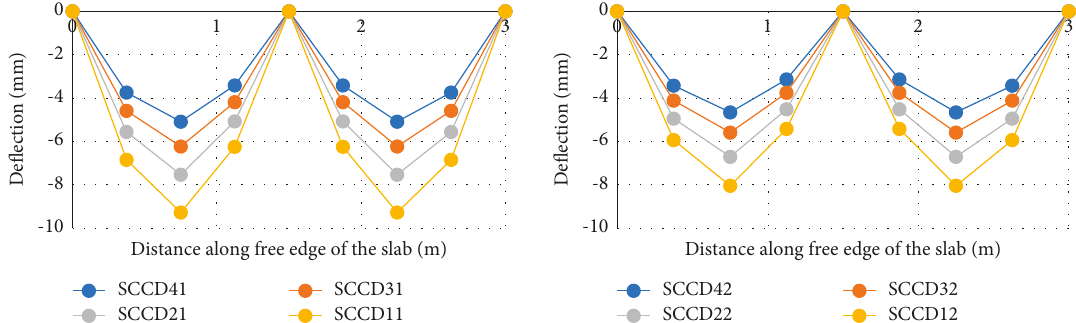
Figure 13: Effect of concrete grade on slab deflection.